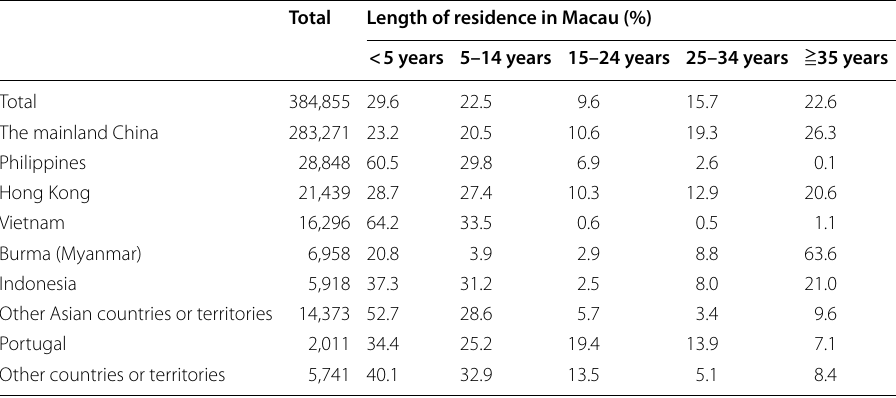
Table 2 Length of residence in Macau and the non-Macau-born land-based population. Source : Adapted from DSEC